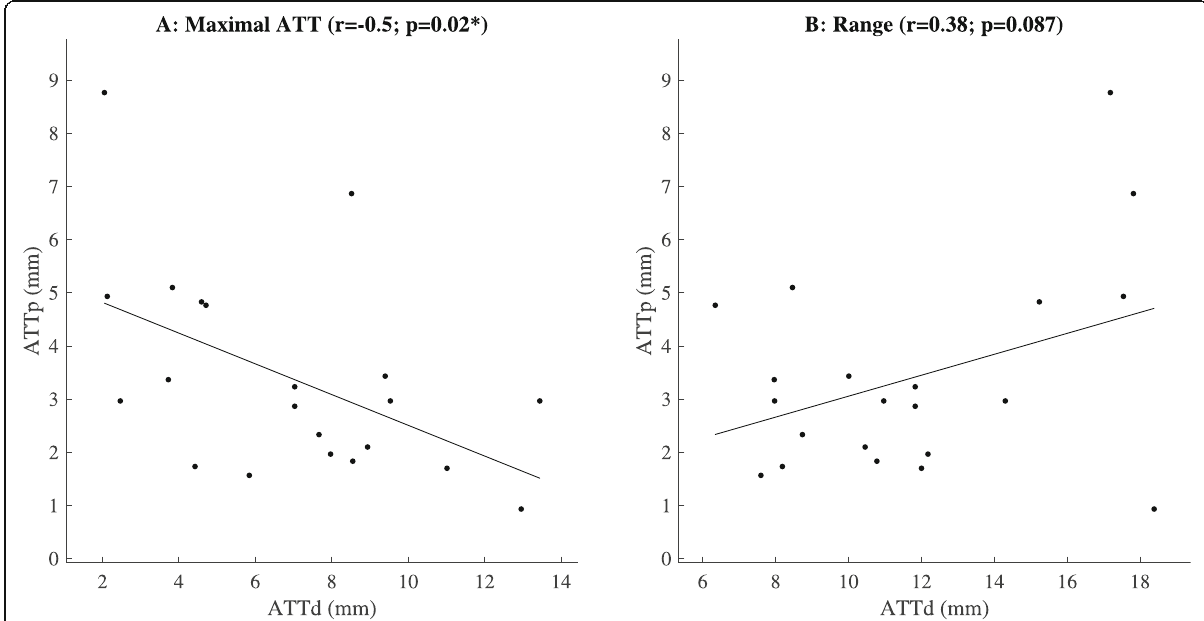
Fig. 3 Passive anterior tibia translation (ATTp; KT-1000 arthrometer) v.s. the maximal dynamic anterior tibia translation (ATTd) and the range of dynamic anterior posterior tibia translation during a single hop for distance; *: